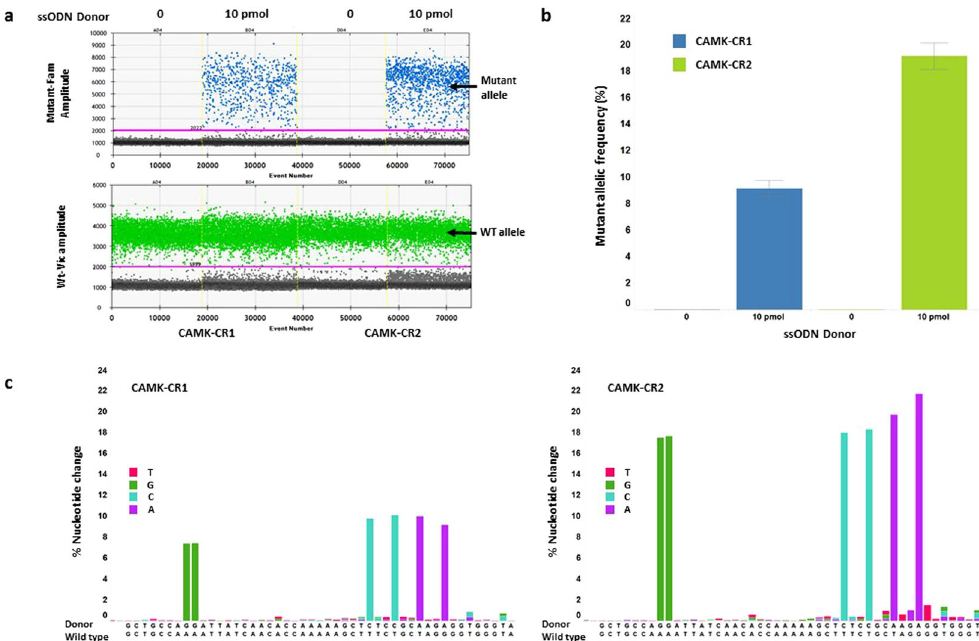
Figure 2. An optimized method for co-delivery of a single-stranded oligonucleotide (ssODN) donor and sgRNA/Cas9 mRNA to perform HDR at the CAMK2D locus in mc-iPSCs. sgRNA CAMK-CR1 or CAMK-CR2, Cas9 mRNA and ssODN donor C-CR2 were co-transfected into mc-iPSCs using the EditPro ™ RNA transfection reagent ( a ) The percent wild type and mutant alleles from the transfected cells were detected by droplet digital PCR (ddPCR) using a wild type alleles specific fluorescence probes (VIC) and mutant alleles specific fluorescence probes (FAM), the fluorescence intensity of each droplet in the sample is plotted versus droplet number. Droplets that have fluorescence intensity above the pink threshold line are counted as positive for the target alleles. The bottom panel (green) represents the droplet of wild type alleles while the top panel (blue) represents the alleles that have undergone HDR. The data presented is from one representative experiment using the two sgRNAs at the best concentration of ssOND, 10 pmol. ( b ) Quantification of mutant allelic frequency. Data presented as mean ± SEM from four independent experiments. sgRNA CAMK-CR2 consistently produced HDR at greater than 15% of the total alleles. ( c ) Quantification of the intended nucleotide changes by next generation sequencing using the same sgRNA and donor used for the ddPCR experiments. Each bar represents one of the six nucleotide changes included on the donor oligo. The data indicates that complete sequence conversion occurred across the targeted region and at frequencies that were in agreement with the ddPCR results. The two A to G changes not directly measured by ddPCR were also incorporated albeit at lower frequencies compared to those changes that were closer to the CRISPR cleavage site. The data presented is the mean percent intended base alteration at each of their exact genomic coordinates from four independent experiments.